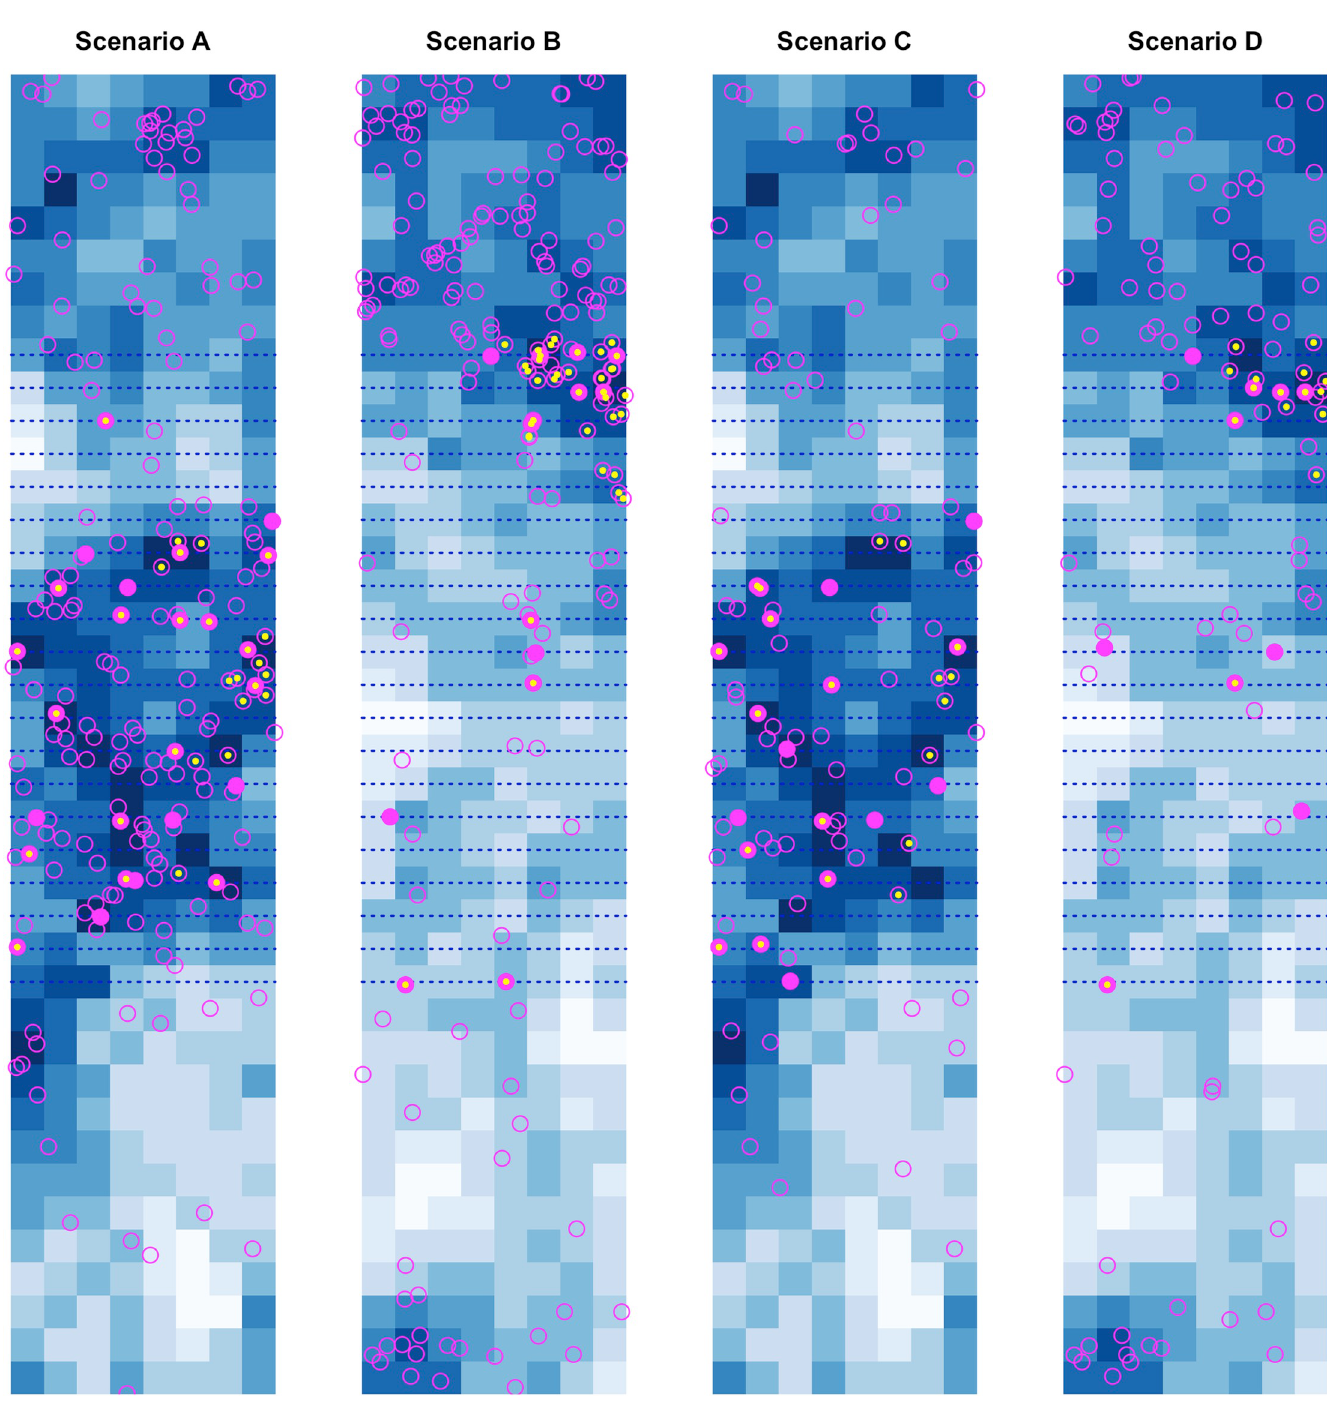
Fig 3. Individual distribution patterns in the final survey year under the four contrasting scenarios. Blue dotted lines indicate transect lines. Filled magenta points indicate individuals detected in the line-transect survey; open magenta points indicate undetected individuals; yellow points indicate individuals identified from either the survey vessel or the small